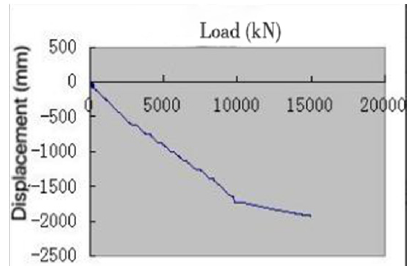
Figure 3. Loading Figure 3. Loading process.